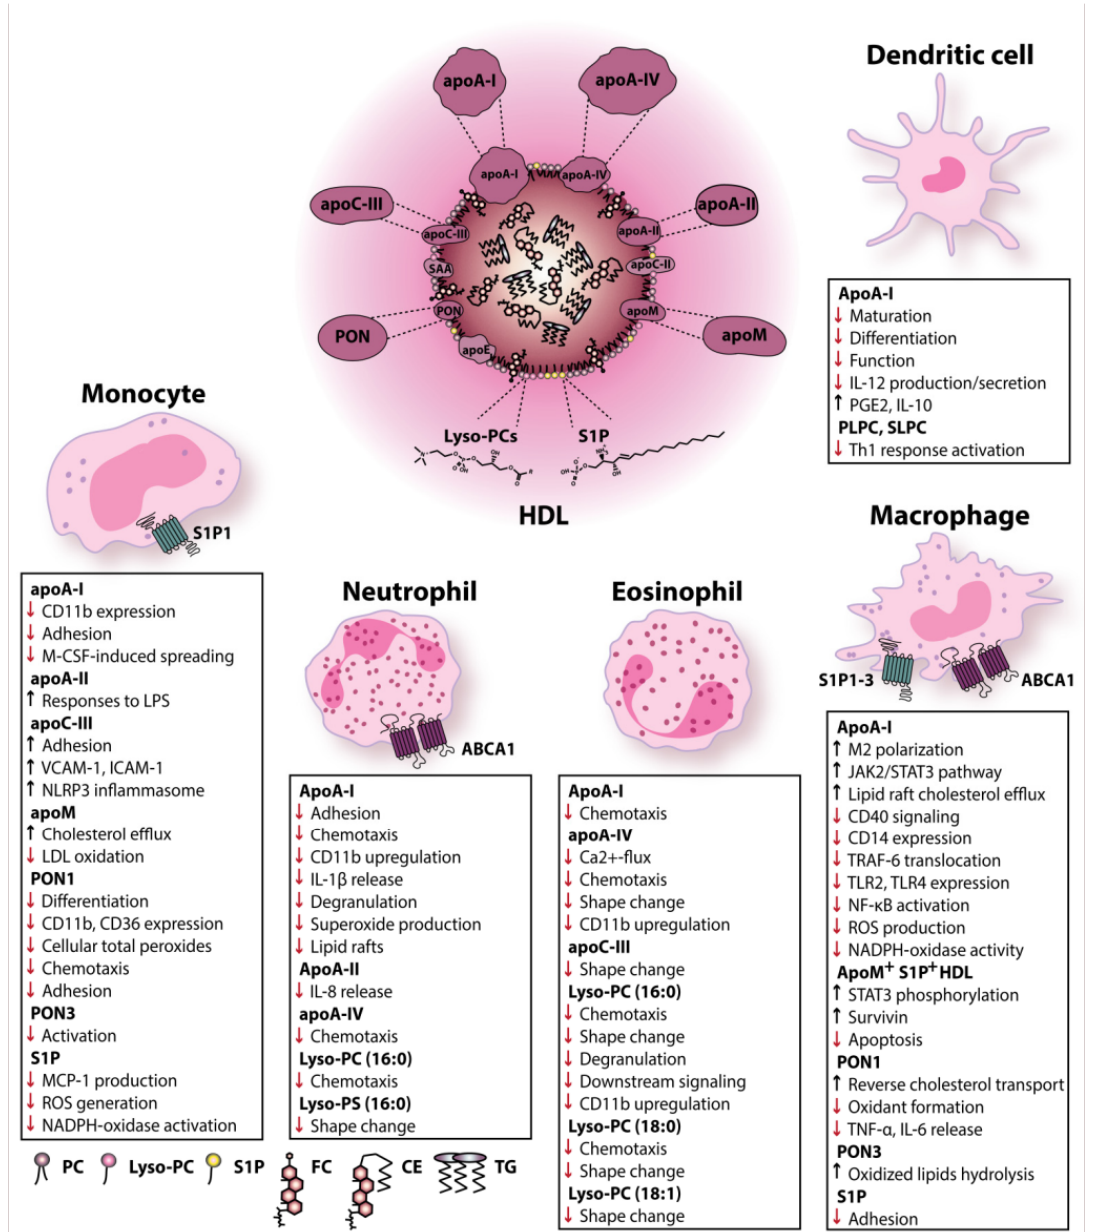
Figure 1. Effects of HDL-associated or purified apolipoproteins, lipids and enzymes in immune cell activation and function in vitro. Abbreviations: ABCA1—ATP-binding cassette subfamily A member 1; apoA-I—apolipoprotein